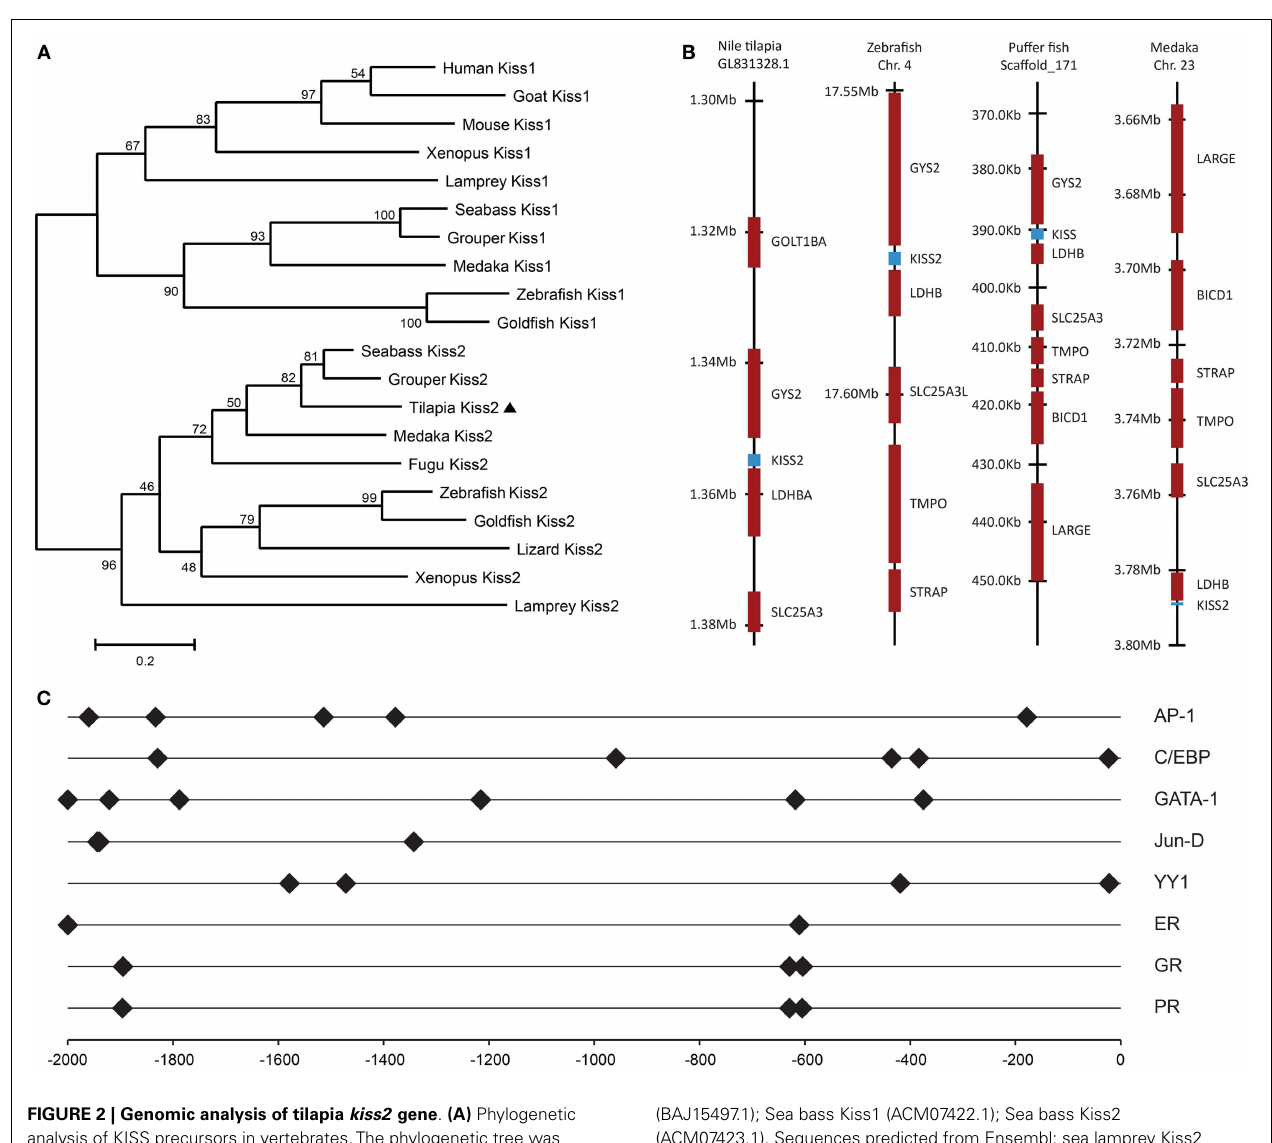
FIGURE 2 | Genomic analysis of tilapia kiss2 gene . (A) Phylogenetic analysis of KISS precursors in vertebrates.The phylogenetic tree was constructed by MEGA 4.0.2 using the neighbor-joining method with 1000 bootstrap replicates.The number shown at each branch indicates the bootstrap value (%). GenBank accession numbers for KISS: human KISS1 (NP_002247.3); Mouse KISS1 (AAI17047.1); Goat KISS1 (ACI96030.1); Clawed frog Kiss1 (NM_001170453.1); Clawed frog Kiss2 (NM_001162860.1); Zebrafish Kiss1 (NP_001106961.1); Zebrafish Kiss2 (NP_001136057.1); Grouper Kiss1 (ADF59544.1); Grouper Kiss2 (ADF59545.1); Medaka Kiss2 (NP_001153913.1); Fugu Kiss2